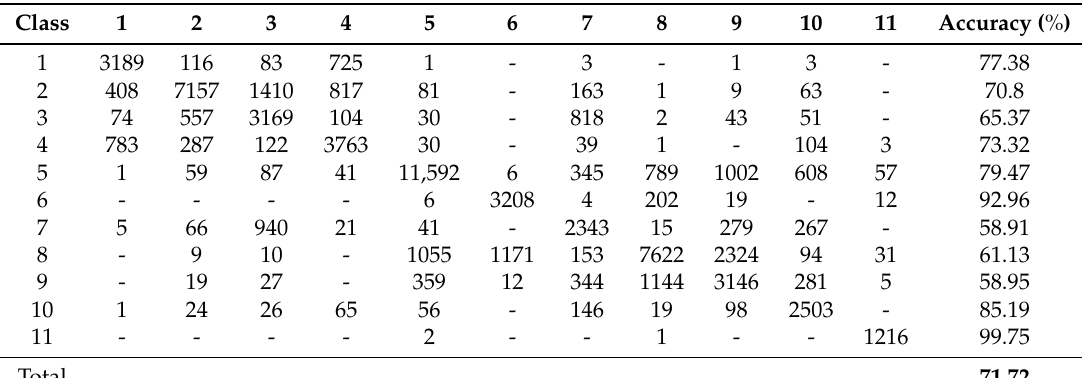
Table 2. Confusion matrix for Flevoland I data using SVM.